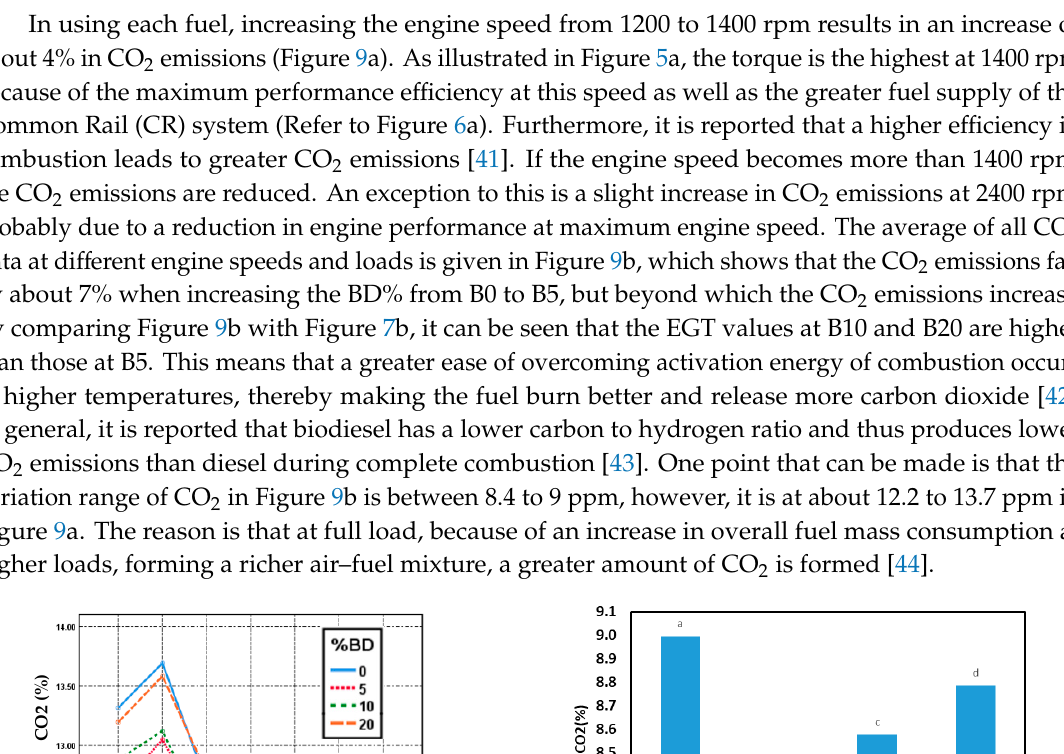
Figure 8. ( a ) NOx vs. S at 100% load; ( b ) mean values of total data of NOx for different speeds and loads. The letters a-d inside the diagram indicate significant differences ( P ≤ 0.05).